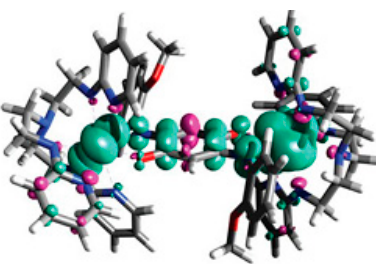
Figure 25. spin-density plot of the [U(L)] 2 Q OMe . Plot surfaces displayed with an iso-value of 0.02 au (reprinted with permission from [156], the Royal Society of Chemistry, 2017).